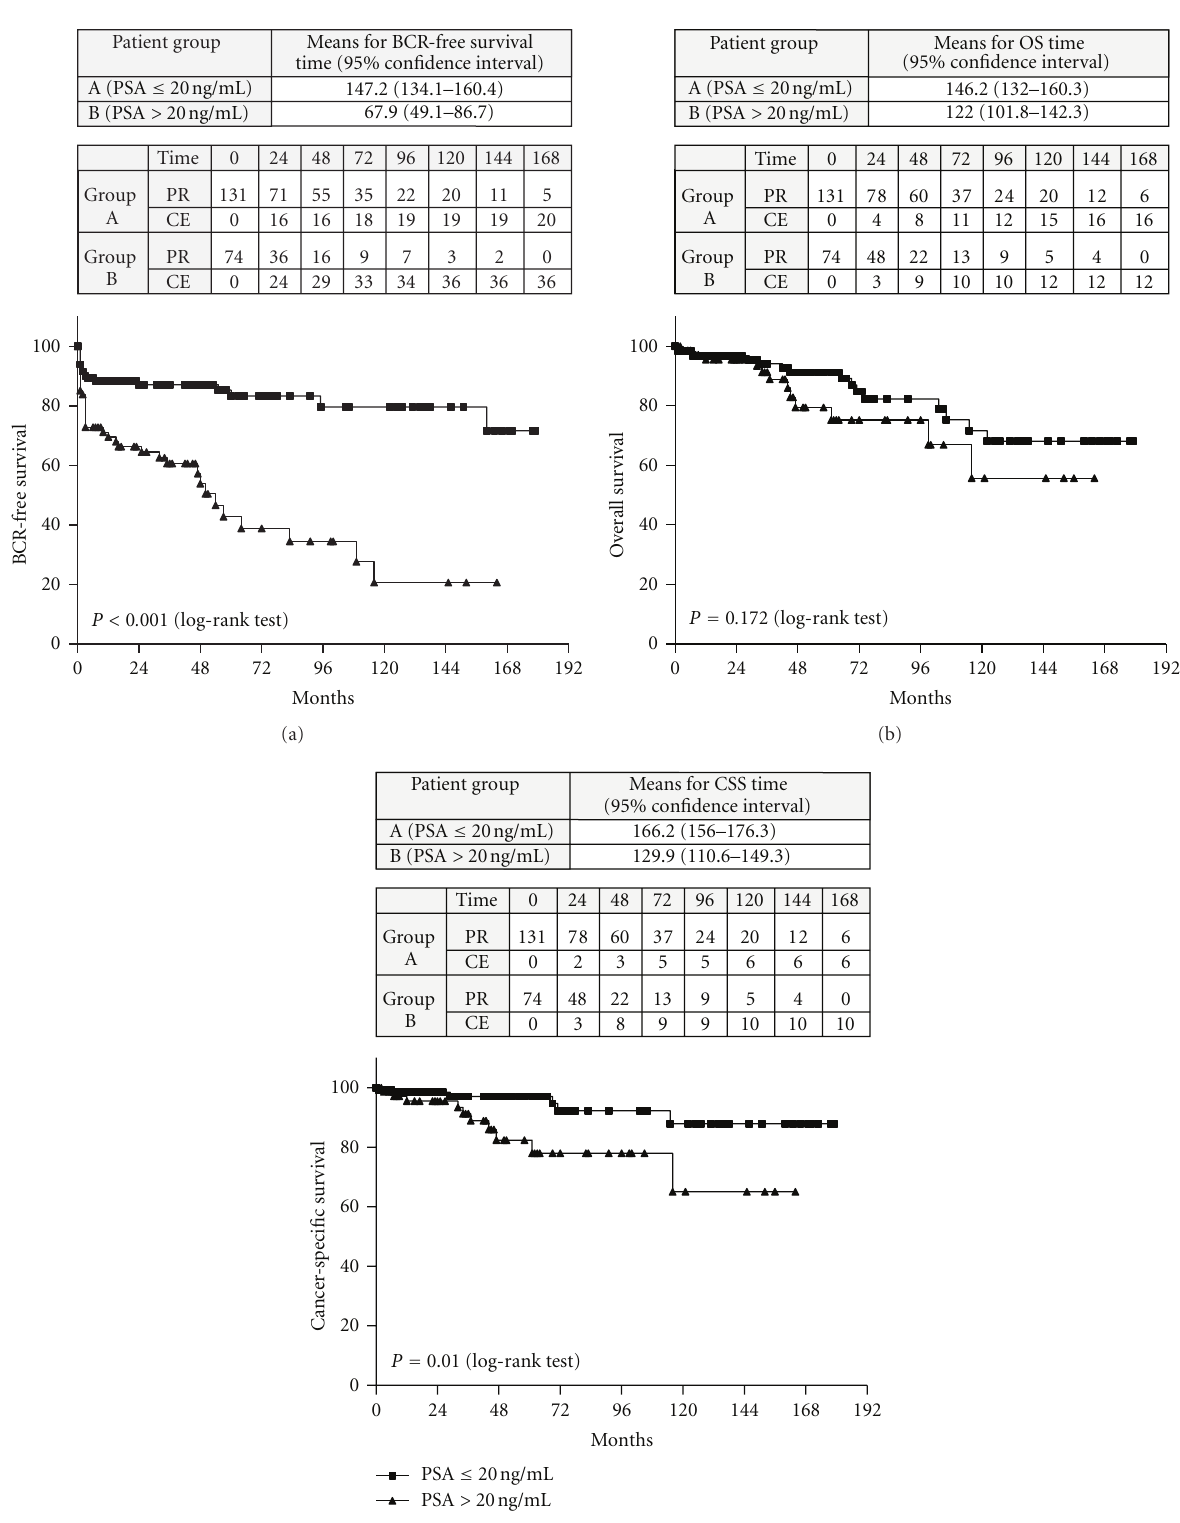
Figure 1: (a) Kaplan-Meyer curves distribution: comparison between patients with PSA ≤ 20 ng/mL versus patients with PSA > 20 ng/mL with regard to BCR-free survival rates. PR: patients at risk; CE: cumulative number of events. (b) Kaplan-Meyer curves distribution: Com- parison between patients with PSA ≤ 20 ng/mL versus patients with PSA > 20 ng/mL with regard to OS survival rates. PR: patients at risk; CE: cumulative number of events. (c) Kaplan-Meyer curves distribution: comparison between patients with PSA ≤ 20 ng/mL versus patients with PSA > 20ng/mL with regard to CSS survival rates. PR: patients at risk; CE: cumulative number of